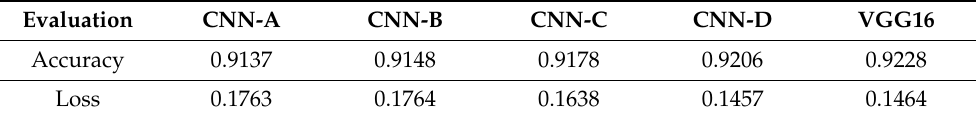
Table 3. Comparison of the accuracy and loss between our models and the baseline.